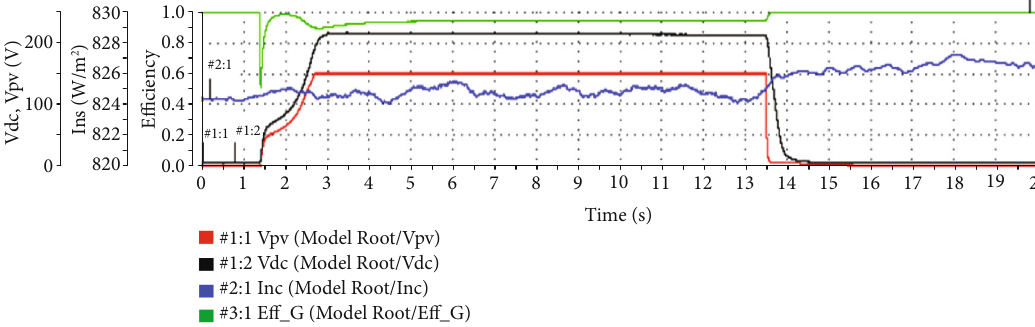
Figure 17: Voltage characteristics.